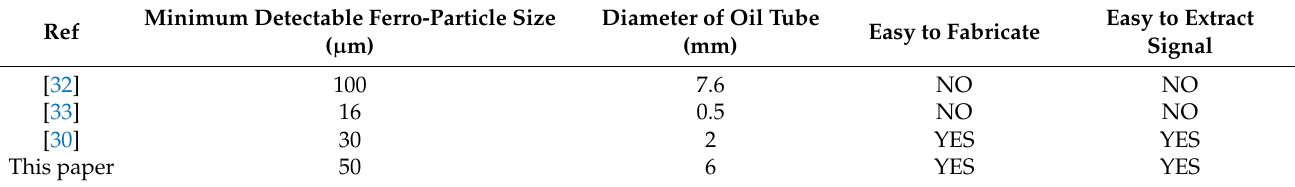
Table 3. Comparation with other